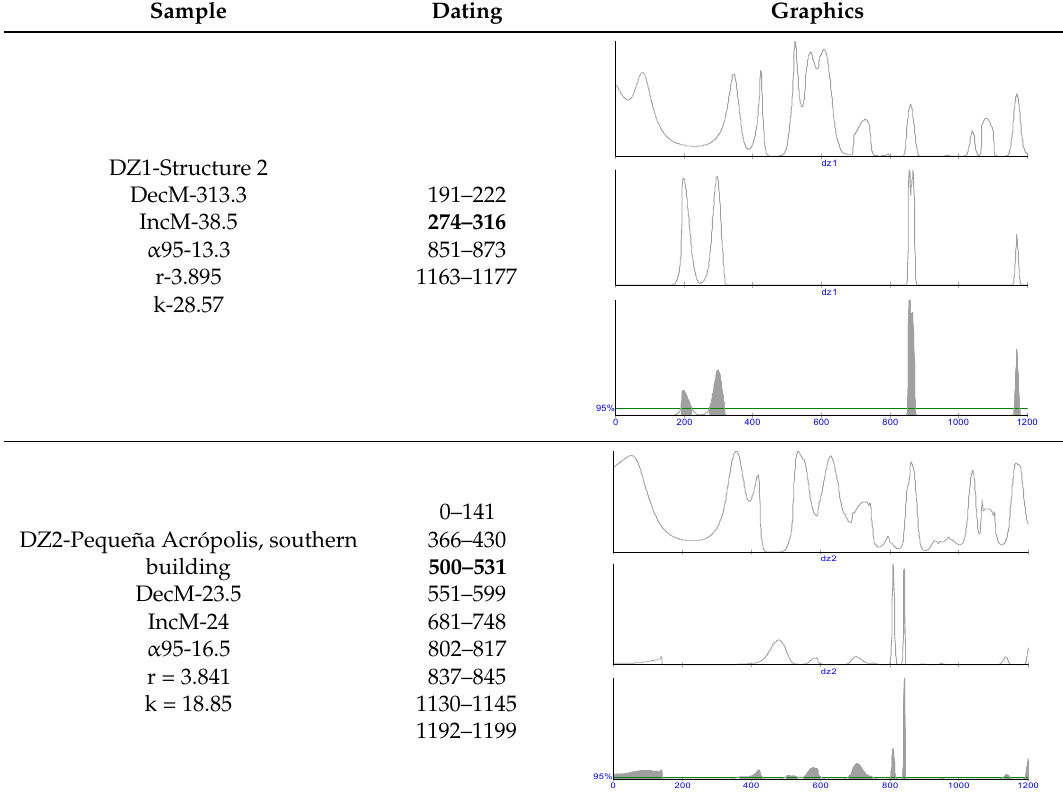
Table 13. Archaeomagnetic dates: the archaeomagnetic method yields many date ranges because the values of magnetism in the earth have been similar in many periods. The ranges in bold are the ones that were in agreement with the archaeological data.